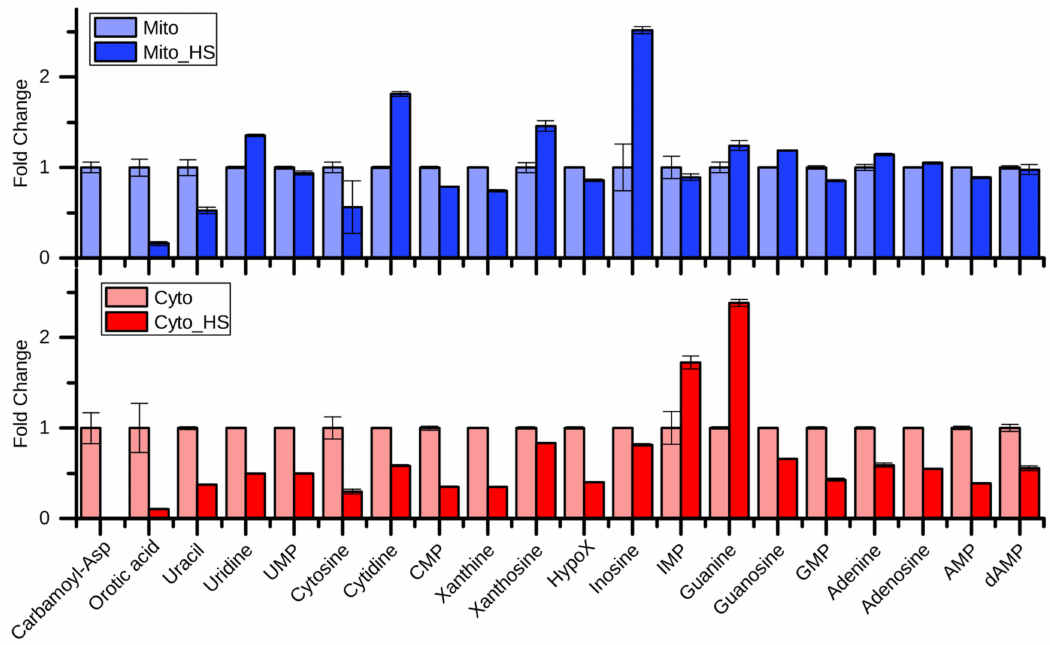
Figure 3. Fold change of purine and pyrimidine metabolism related metabolites after heat stress. Carbamoyl-Asp: carbamoyl-aspartate; HypoX: